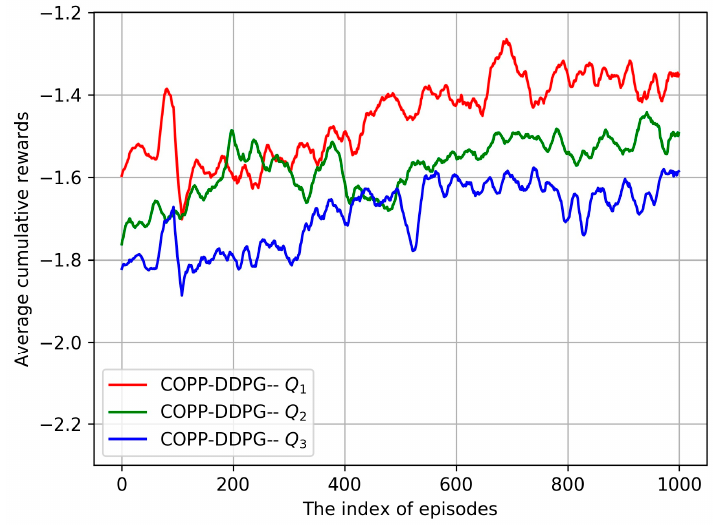
Figure 4. Convergence of COPP-DDPG with three different priorities Q i .